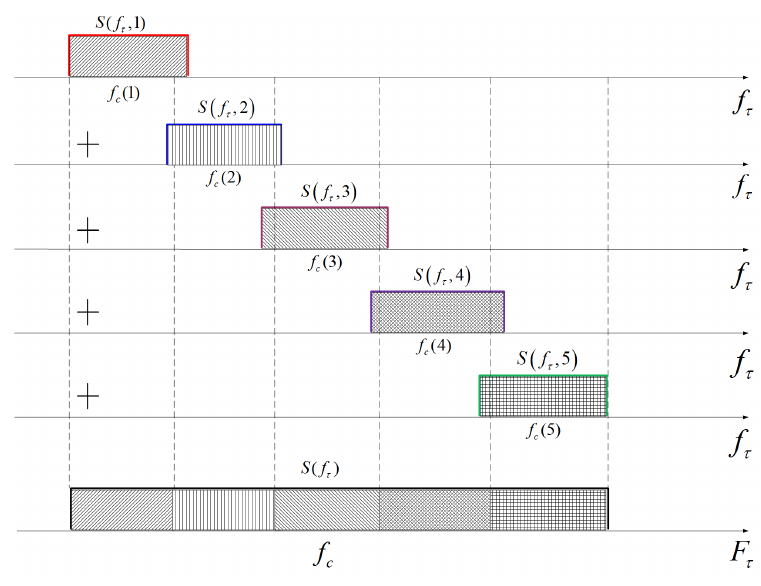
Figure 7. Schematic diagram of the cut-paste